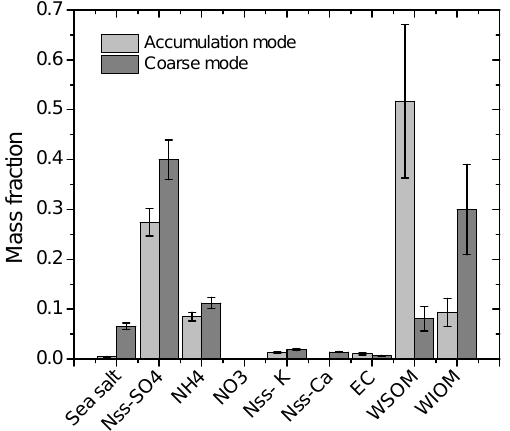
Figure 4. Average mass fraction of organic and inorganic species in the accumulation and coarse modes of the ZOTTO